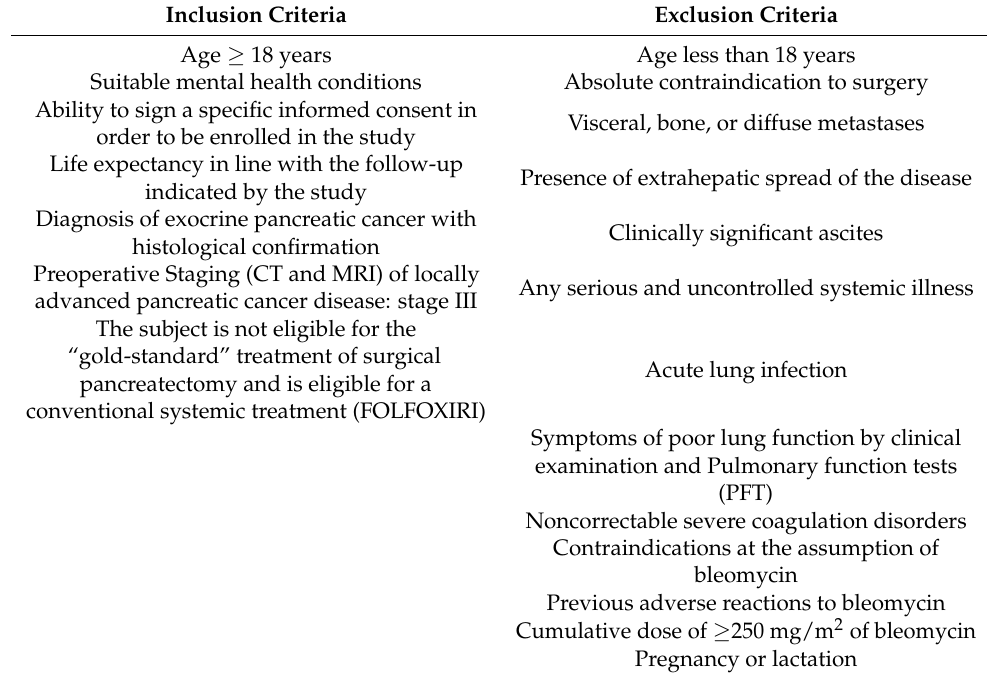
Table 1. Inclusion and exclusion